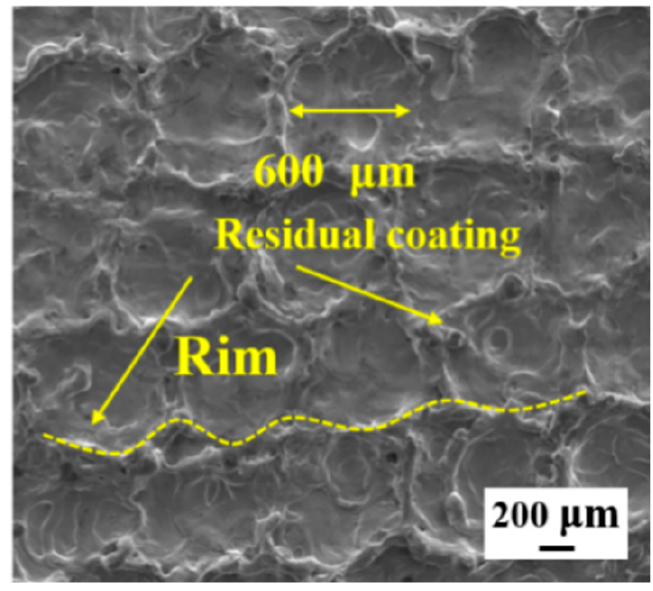
Figure 10. The microscopic structure of the surface of the Y-1 sample.